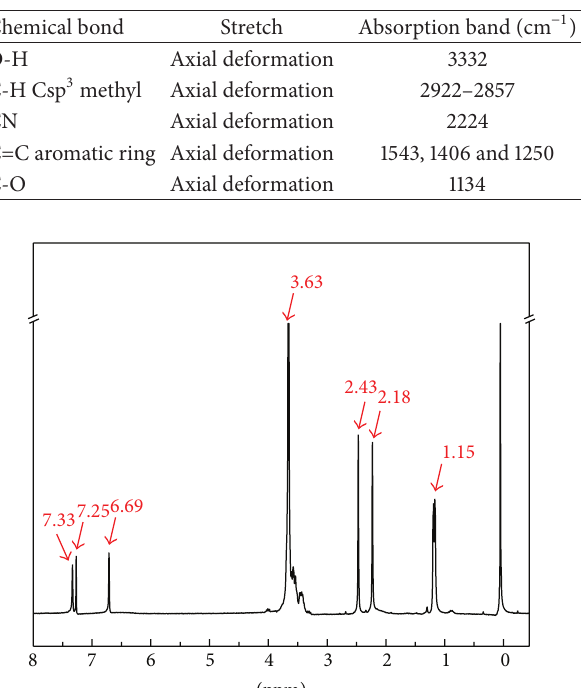
the solvent and temperature, being generally in the left ( 𝛿 ∼ 7.5 to 𝛿 ∼ 4.0 ppm) of hydrogen atom sign of hydroxyl of alcohol. Signals at 6.69 and 7.52 ppm correspond to protons of aromatic ring and signals at 2.32 and 2.17 ppm correspond to methyls groups to the aromatic ring [15].